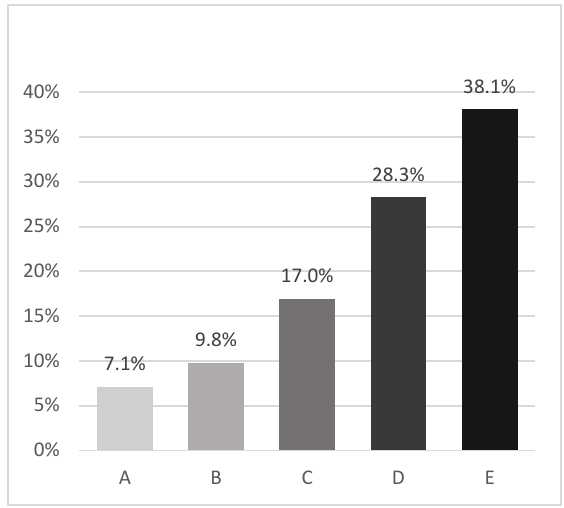
Figure 3 . Composite incidence (%) of catheter-related clinically relevant complications. BSI, Bloodstream infection. DVT, Deep venous thrombosis. A—Catheter-related BSI; B—Catheter-related DVT; C—A + B; D—Mechanical complications + C; E—Catheter malfunction + D.